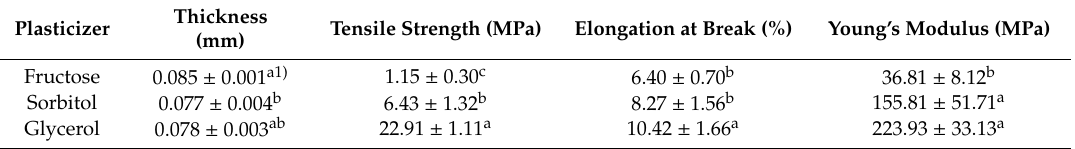
Table 1. E ff ect of plasticizer type on the mechanical properties of the C. junos pectin (CJP) film.